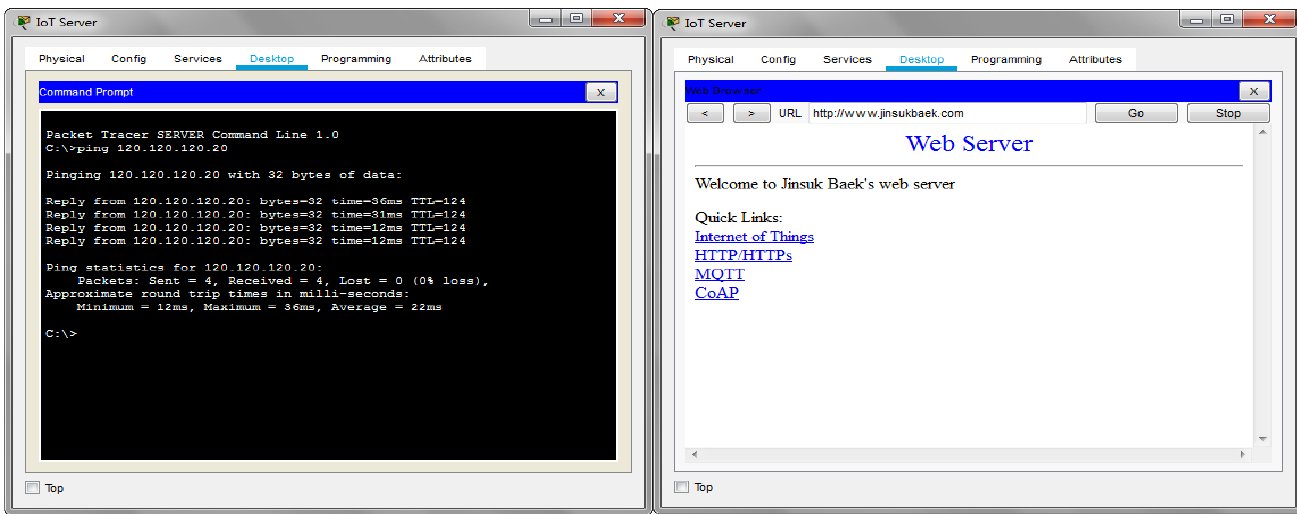
Figure 9. Access to external network from host on the